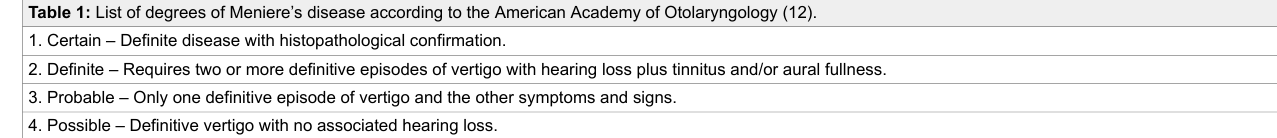
Table 1: List of degrees of Meniere’s disease according to the American Academy of Otolaryngology (12). 1. Certain – Definite disease with histopathological